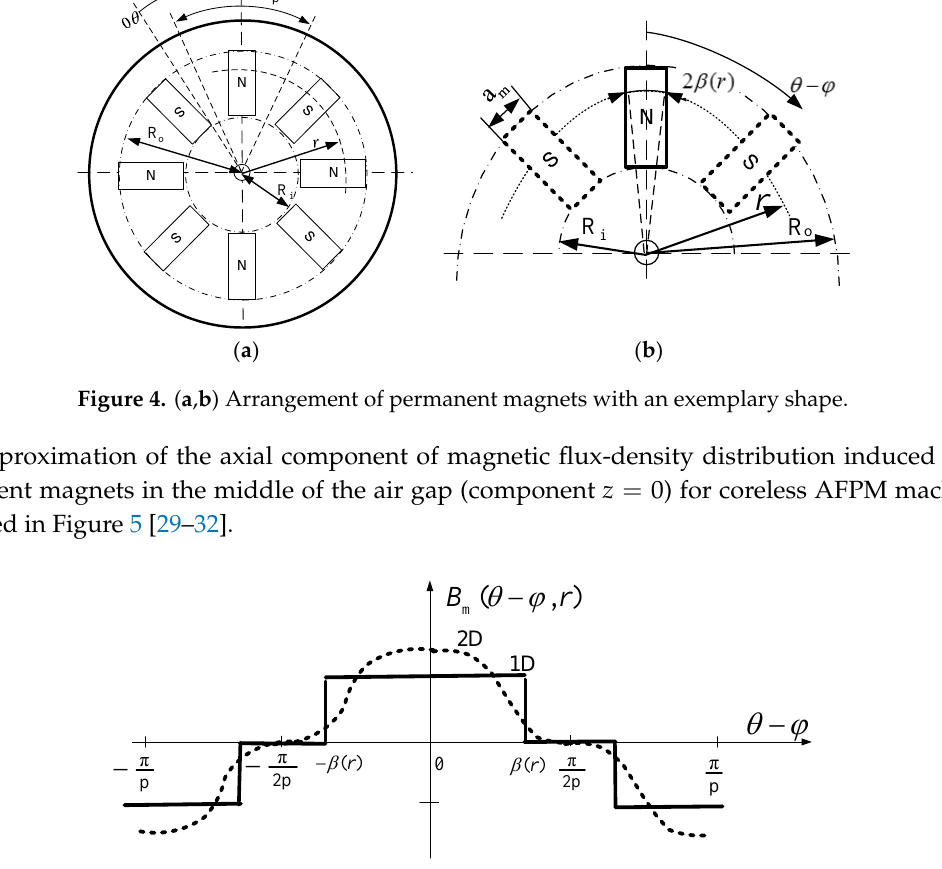
Figure 3. Basic model to illustrate the magnetic field distribution from permanent magnets in the air gap.